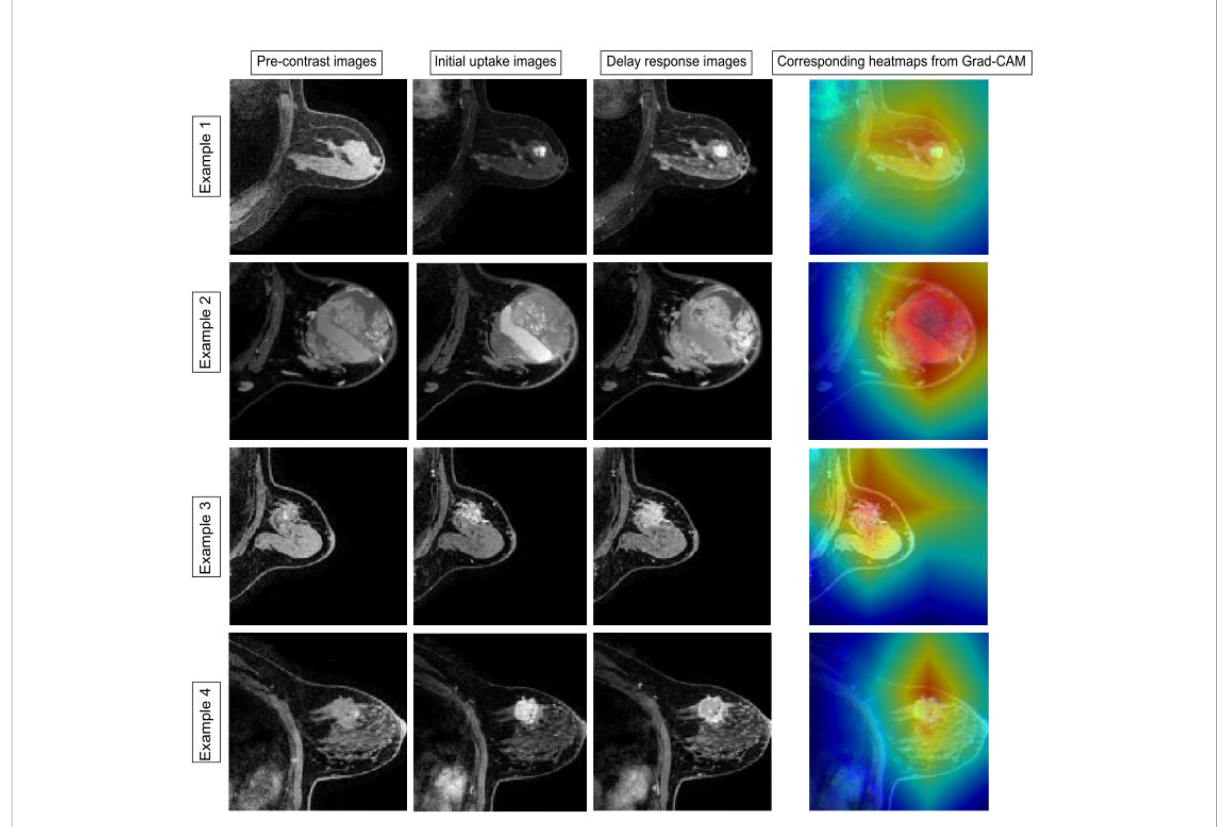
FIGURE 5 Examples of the attended regions through the Grad-CAM. The pathological types of the four cases were adenosis, benign lobular tumor, ductal carcinoma in situ , and invasive carcinoma. With the visual model display, the brighter area that contains lesion extent can be observed, demonstrating that the classi fi cation model can focus on the lesion area